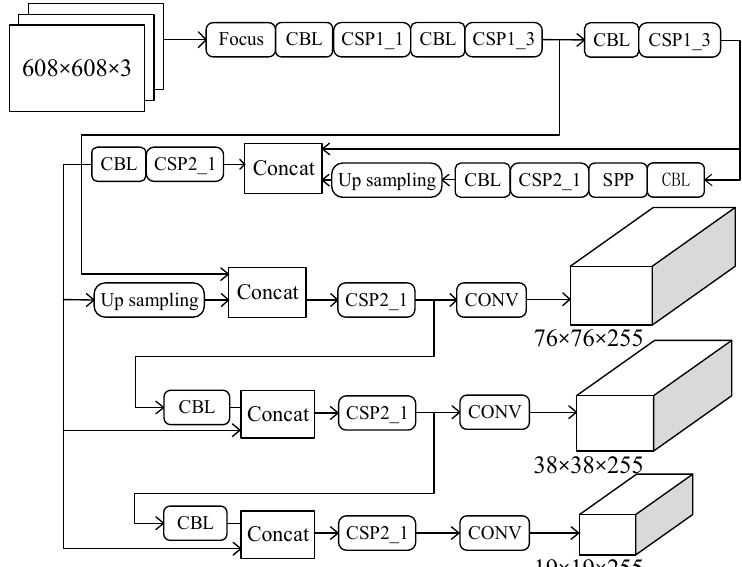
Figure 2. YOLOv5 network structure diagram.